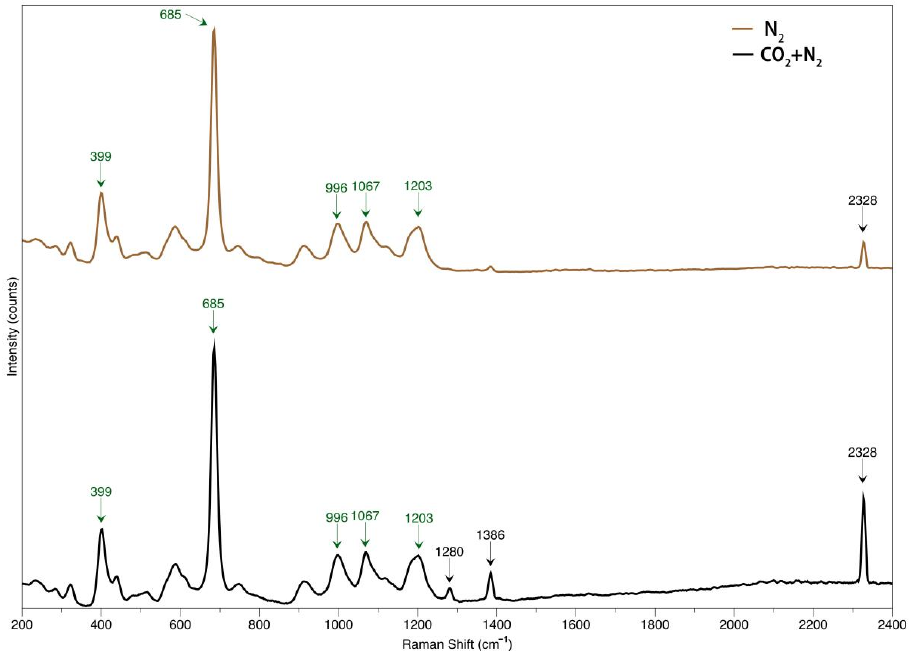
Figure 21. Raman spectrum detected CO 2 and N 2 within the voids, with prominent peaks at 1280 and 1386 cm − 1 and at 2328 cm − 1 , respectively.